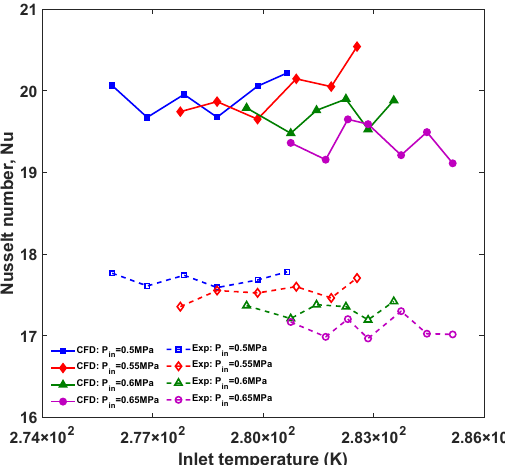
Figure 14. Comparison of the experimental dp for different mass flux values and p = 0.65 MPa.